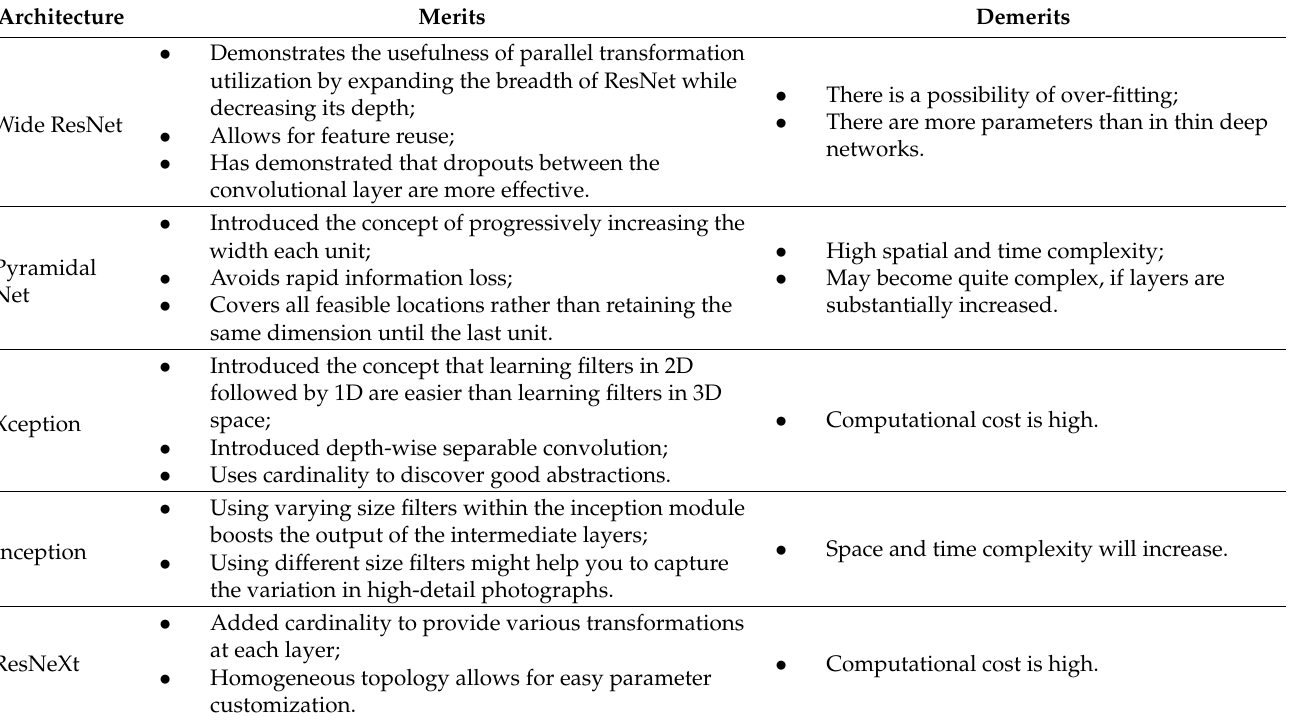
Table 5. Major issues linked with the deployment of width-based CNN architectures.